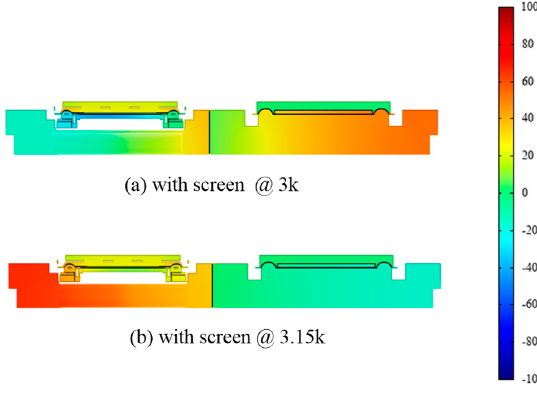
Figure 12. Sound pressure distribution (with screen).